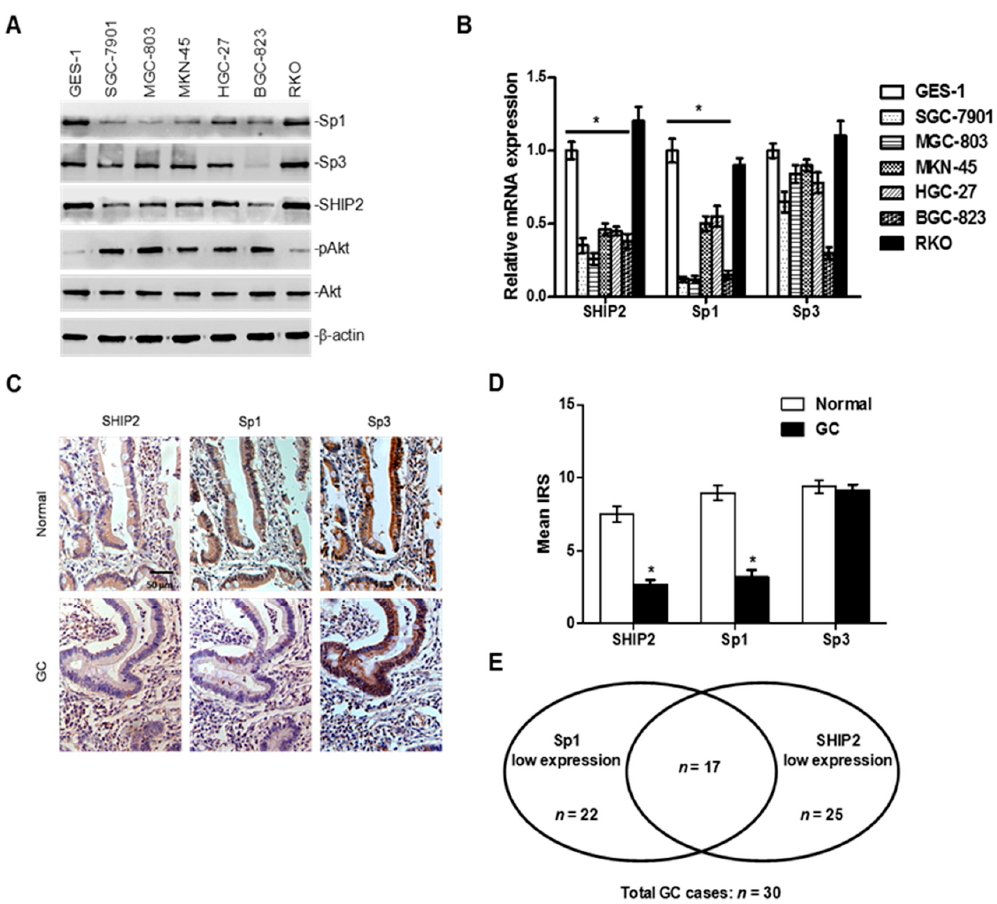
Figure 2. Decreased Sp1 expression parallels SHIP2 downregulation in GC cells. ( A ) Whole cell lysates from the normal gastric mucosa epithelial cells GES-1, a panel of GC cells and the human colon cancer cells RKO were subjected to Western blot analysis. Data shown are representative of 3 individual experiments; ( B ) the mRNA expression levels of SHIP2, Sp1 and Sp3 from GES-1, RKO and a panel of GC cells were analyzed by qRT-PCR. The relative abundance of target gene mRNA expression in GES-1 was arbitrarily designated as 1 ( n = 3, mean ± SEM, * p < 0.01 vs. GES-1); ( C ) representative images of immunohistochemical staining of SHIP2, Sp1 and Sp3 (brown) on tissue sections from matched pairs of GC. Scale bar, 50 μ m; ( D ) quantitation of SHIP2, Sp1 and Sp3 expression levels in gastric tumors ( n = 30, mean IRS ± SEM, * p < 0.001 vs. normal mucosa tissues); ( E ) low expression of Sp1 and/or SHIP2 in GC tissues in vivo. Results were derived by quantitation of Sp1 and SHIP2 positive GC cells on tissue sections as shown in Figure 2C,D, and are depicted schematically.